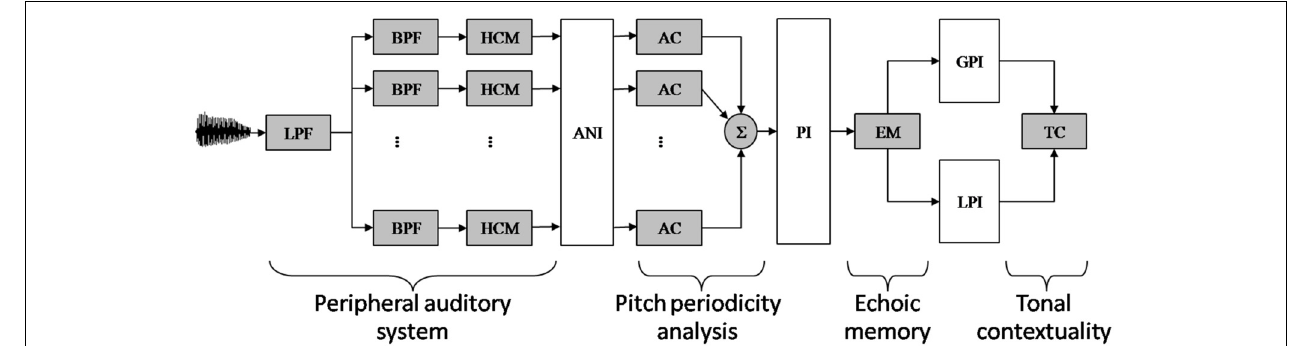
FIGURE 1 | Schematic diagram of the auditory memory model of Leman (2000). The model comprises four components, called peripheral auditory system, pitch periodicity analysis, echoic memory, and tonal contextually. (Component 1) Audio signals are first transformed in neural rate-coded representations by a peripheral auditory model based on Van Immerseel and Martens (1992). The filter characteristics of the outer and middle ear are simulated by a low-pass filter (LPF). The filter characteristic of the inner ear is simulated by an array of 40 band-pass filters (BPF). Half-wave rectification and dynamic range compression simulates the conversion of the band-pass-filtered signals into neural rate-code patterns by the hair-cells (HCM). (Component 2) The resulting auditory nerve image (ANI) is then